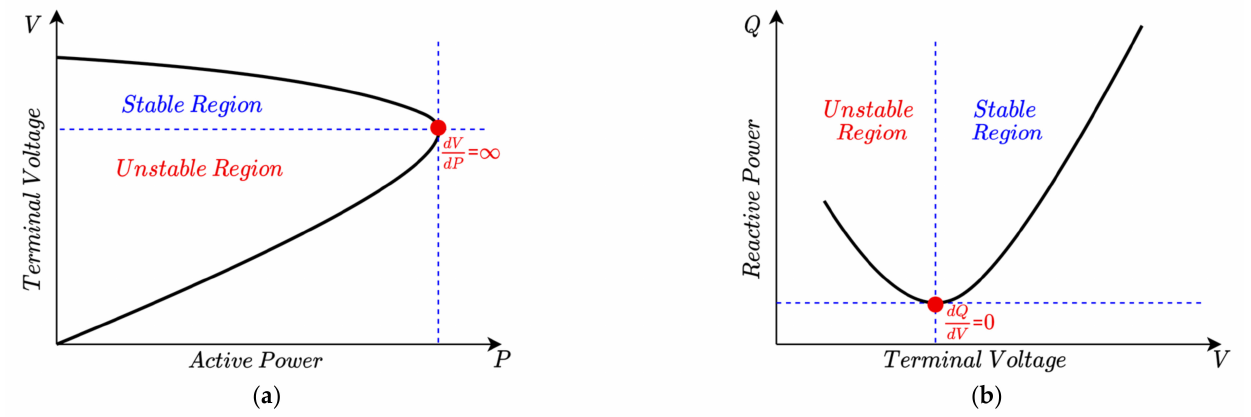
Figure 3. ( a ) P–V and ( b ) V–Q curves obtained for the voltage stability analysis of a power system showing stable and unstable